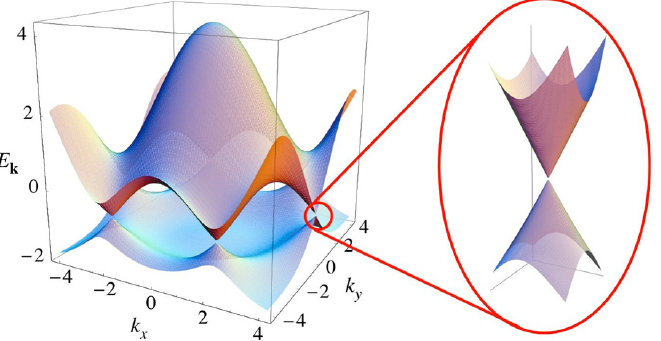
Figure 2. Graphene electronic band structure. Inset: the neighborhood of a Fermi